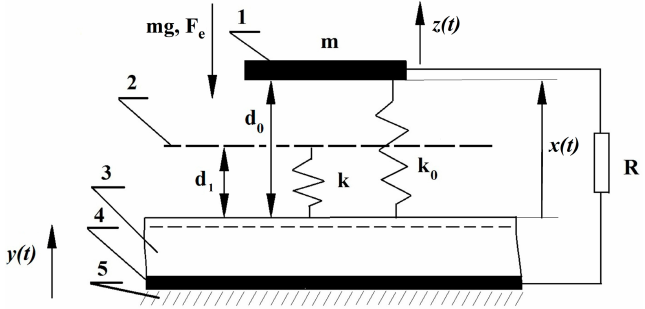
Figure 3. Schematic of the single-capacitor electret generator: 1 —Moving electrode; 2 —Moving stopper; 3 —Electret; 4 —Electrode; and 5 —Frame.